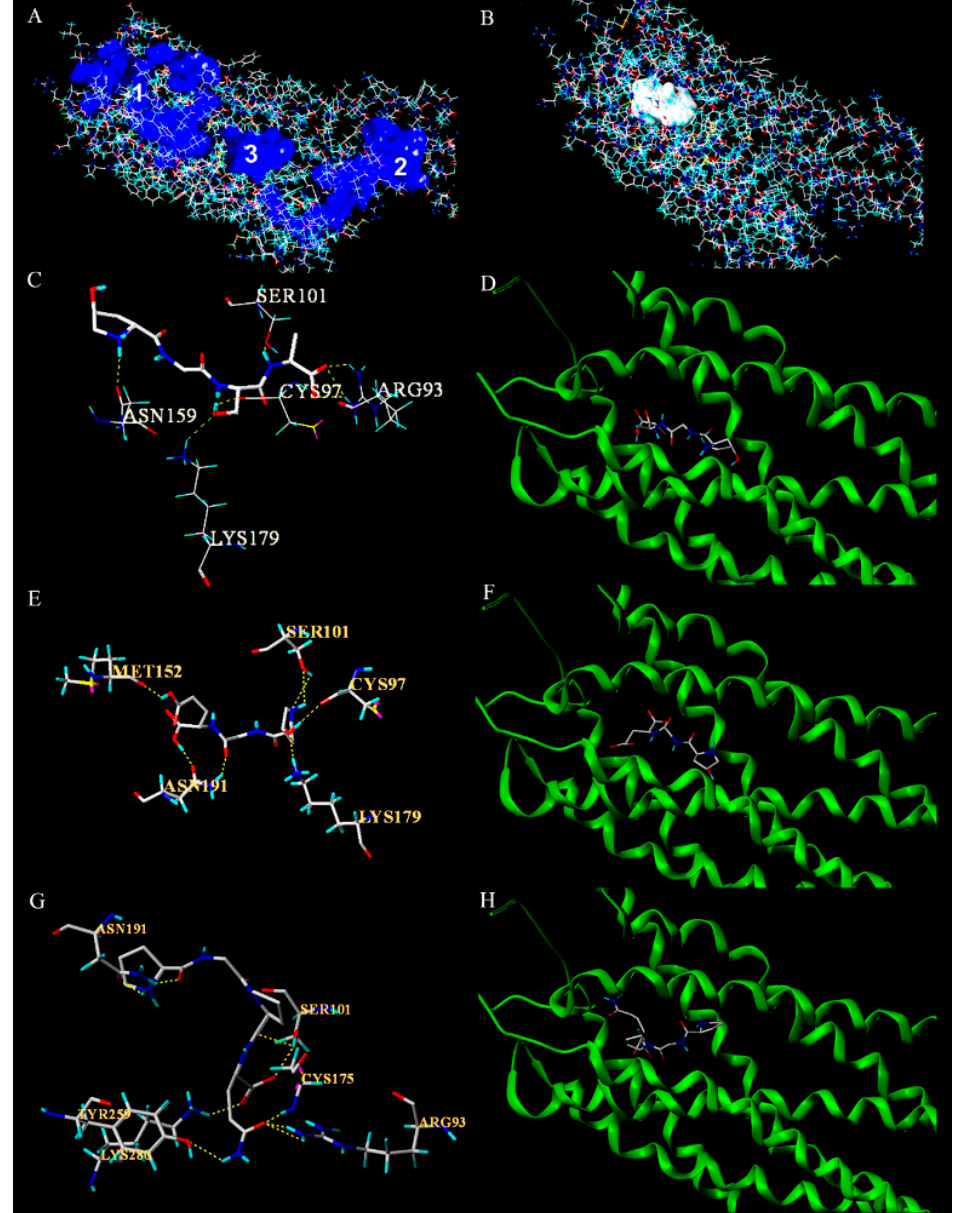
Figure 5. Molecular docking. ( A ) Three binding pockets on the surface of the P 2 Y 12 receptor. ( B ) The pocket 1. ( C ) Docking of OGSA inside the receptor-binding site of P 2 Y 12 , showing hydrogen bonds with the catalytic sites (Asn159, Cys97, Ser101, Arg93, and Lys179). ( D ) The binding diagram of OGSA with P 2 Y 12 . ( E ) Docking of OGE inside the receptor-binding site of P 2 Y 12 , showing hydrogen bonds with the catalytic sites (Met152, Cys97, Ser101, Asn191, and Lys179). ( F ) The binding diagram of OGE with P 2 Y 12 . ( G ) Docking of PGPQ inside the receptor-binding site of P 2 Y 12 , showing hydrogen bonds with the catalytic sites (Arg 93, Cys175, Ser101, Asn191, Tyr259, and Lys280). ( H ) The binding diagram of PGPQ with P 2 Y 12 . The color of molecular diagram: White, C; Blue N; Aquamarine, H; Red, O; Yellow, S. Yellow dotted line: hydrogen